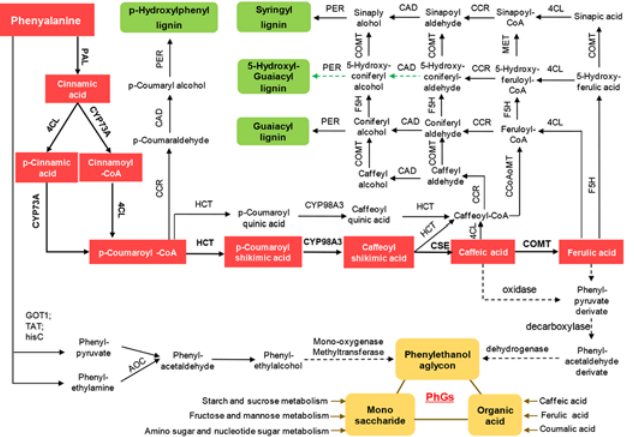
Fig 3. Detailed pathways and genes involved in the synthesis of lignin and PhGs in C . deserticola stem. The top and bottom panels showed the detailed pathways and genes involved in the biosynthesis of four types lignin and PhGs, respectively. Red diamonds represent the common pathway shared by lignin and PhGs. Green dotted lines were used to represent the synthesis pathway of 5-Hydroxyl-Guaiacyl lignin, which was identified in COMT deficient plants. Abbreviation: PAL(Phenylalanine ammonialyas), 4CL (4-coumarate-CoA ligase), CYP73A(trans-cinnamate 4-monooxygenase), CCR(cinnamoyl-CoA reductase), HCT(shikimate o-hydroxycinnamoyltransferase), F5H(ferulate-5-hydroxylase), COMT(3-O- methyltransferase), CCoAOMT(caffeoyl-CoA O-methyltransferase), CAD(cinnamyl-alcohol dehydrogenase), PER(peroxidase), CYP98A3(coumaroylquinate/coumaroylshikimate 3'-monooxygenase), CSE (caffeoylshikimate esterase), GOT1(aspartate aminotransferase), TAT(tyrosine aminotransferase), hisC (histidinol-phosphate aminotransferase) and AOC3(primary-amine oxidase).